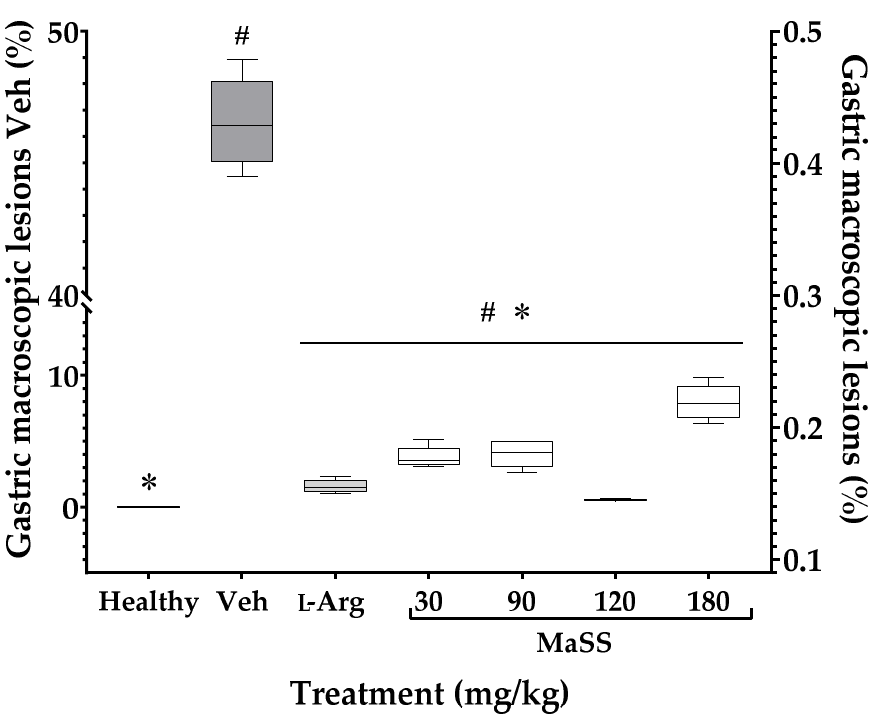
Figure 3. Effect of MaSS at different doses on the percentage of gastric ulcers induced with ethanol in rats. Healthy = rat without gastric lesions, Veh = rat with gastric lesions, L-Arg = L-arginine, MaSS = mixture of kaempferol 3- O -sophoroside and kaempferol 3- O -sambubioside. Kruskal-Wallis analysis with Dunn's multiple comparisons post-test (n = 5, ± ED, # p < 0.05 when groups are compared with the healthy group; * p < 0.05 compared with Veh group).